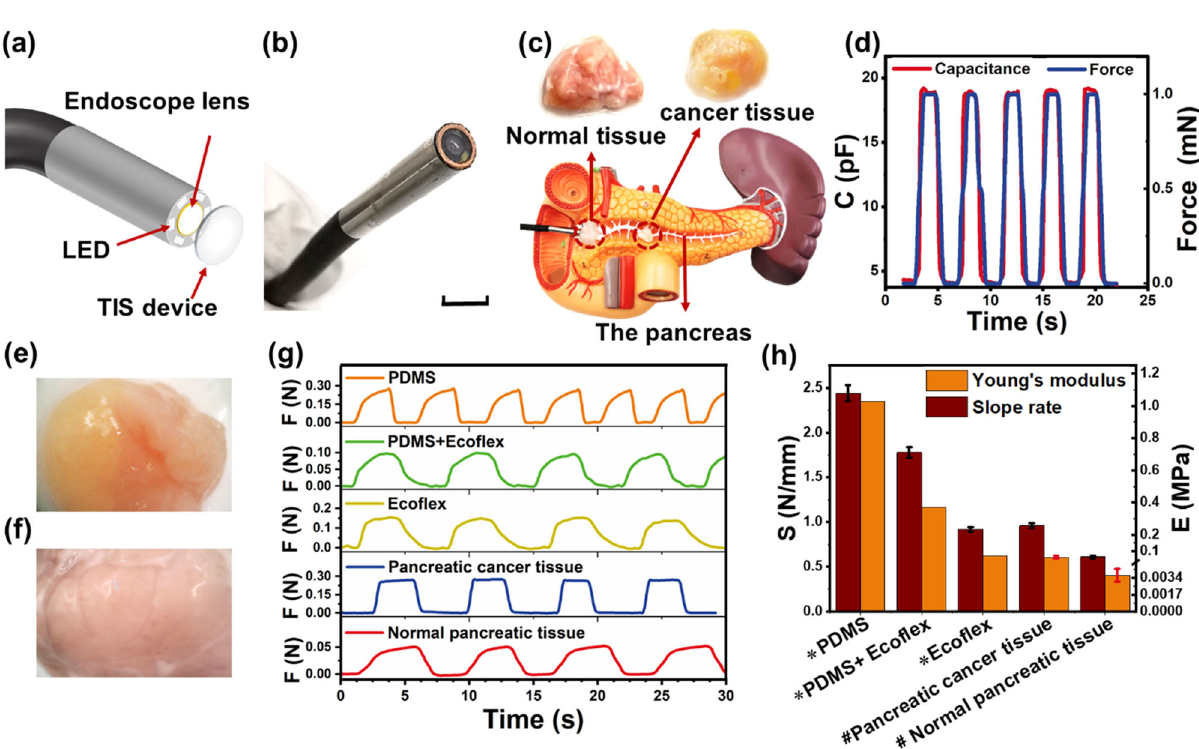
Fig. 6 The demonstration of medicine tactile AI. a The diagram of the TIS device attached on the endoscope lens, b the photos of the TIS- enabled endoscope, c the endoscopic inspection of the TIS-enabled endoscope in a pancreas model, and d the detected tiny force of the contact with the tissue, e the pancreatic cancer tissue and f the normal pancreatic tissue used for stiffness measurement, g the raw data for stiffness measurement of PDMS, PDMS/Eco fl ex mixture, Eco fl ex, pancreatic cancer tissue and normal pancreatic tissue, h the measured slope rates and the calculated Young ’ s modulus (the ‘ * ’ marks the referenced values from standard tensile test and the ‘ # ’ marks the calculated values from Eq. 3) of different samples for stiffness